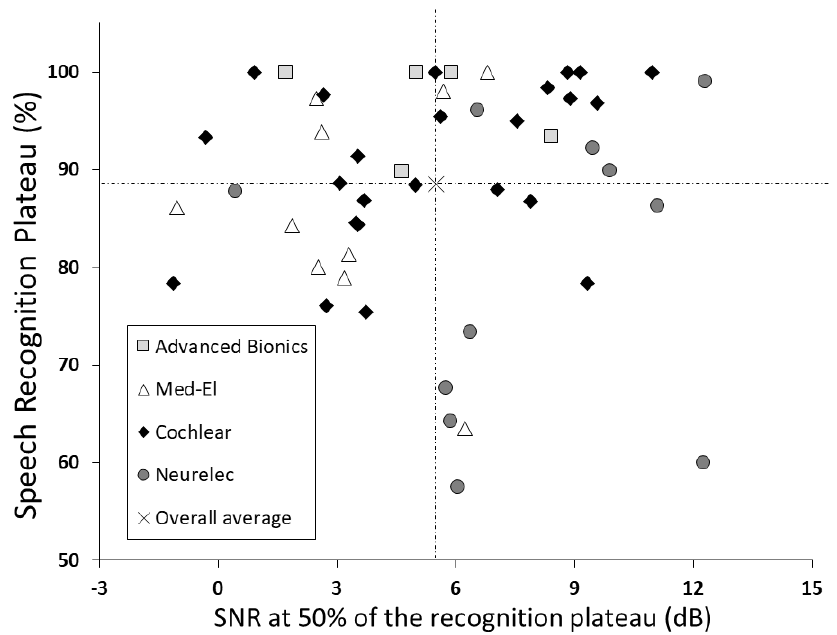
Figure 5. Speech recognition plateau versus the x 50% parameter for cochlear implant users.